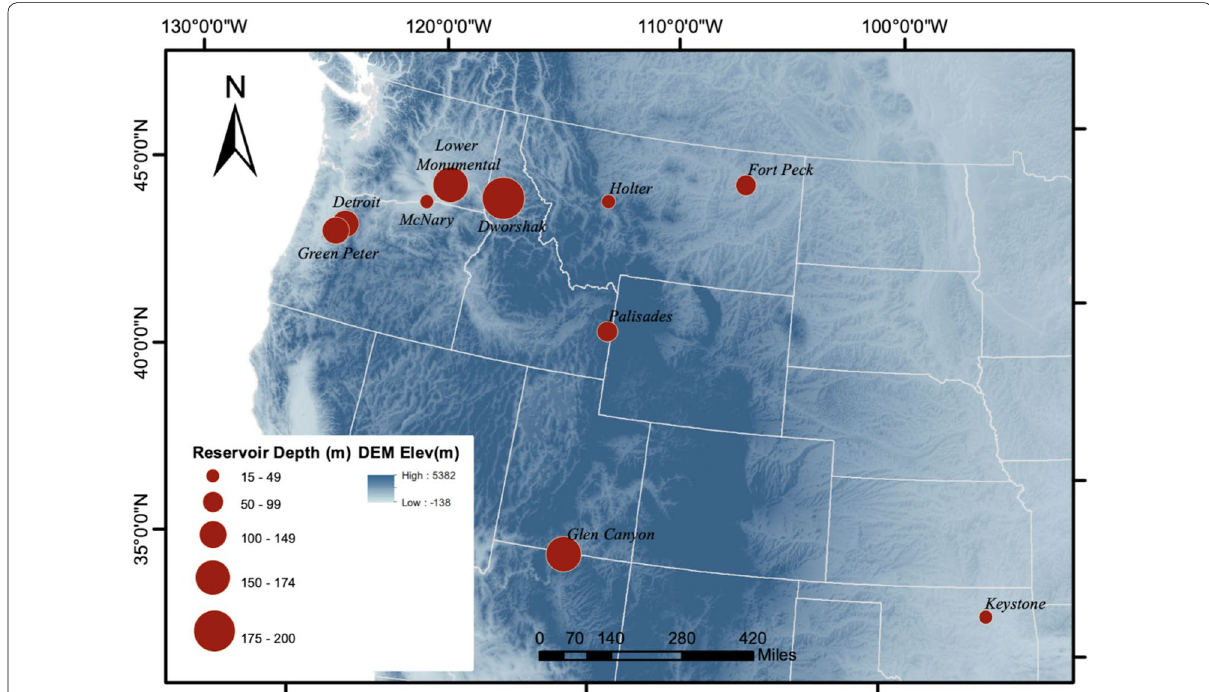
Fig. 4 Selected dams for establishing the remote sensing-based temperature estimation. Markers are sized with their respective average reservoir